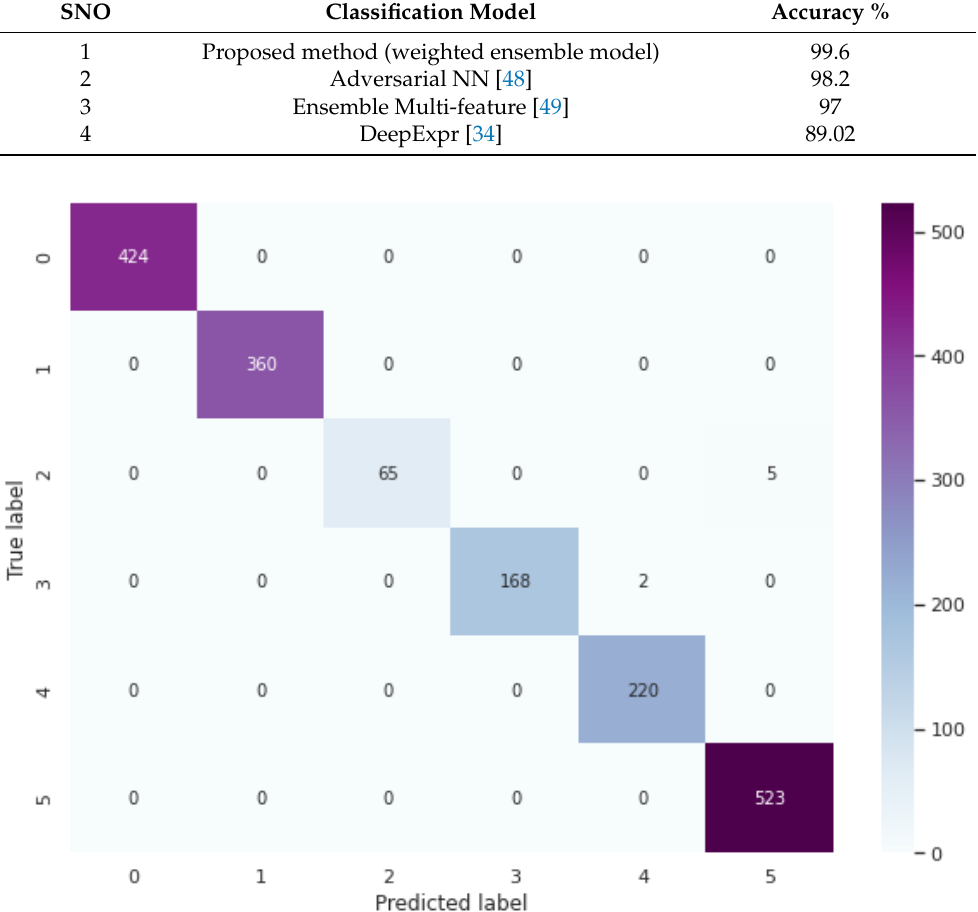
Table 3. Classification accuracy on the FERG-DB dataset.